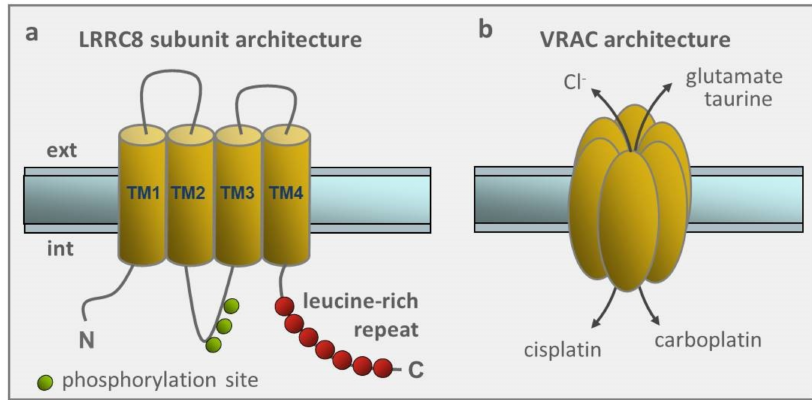
Figure 3. Architecture of LRRC8 subunits and VRAC. ( a ) Transmembrane topology of LRRC8 subunits proposes four transmembrane domains (TM1-4) and a C terminus with up to 17 leucine-rich repeats. LRRC8 subunits have on average multiple phosphorylation sites (indicated here for LRRC8A subunit), and several glycosilation sites (not indicated). ( b ) Hexameric stoichiometry of VRAC, based on its partial homology with pannexin/connexin